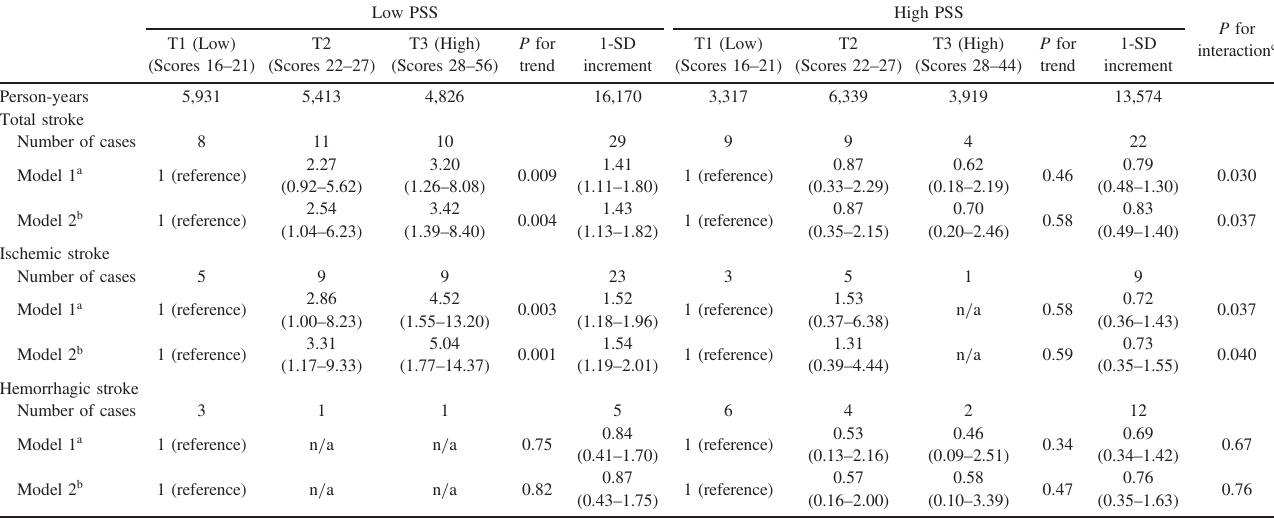
Table 3. Hazard ratios and 95% con fi dence intervals of total stroke and its subtypes based on tertiles of total anger expression strati fi ed by perceived social support